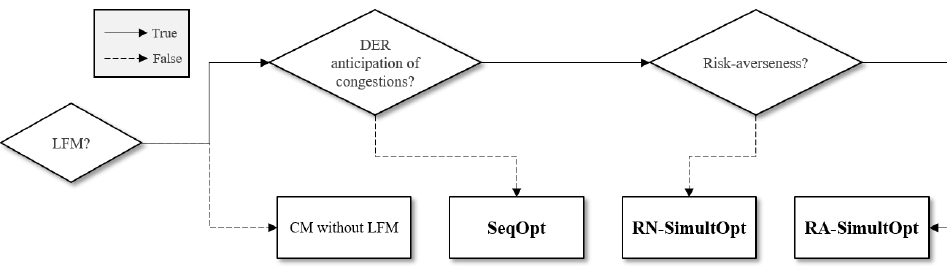
Figure 7. Overview on cases of operational